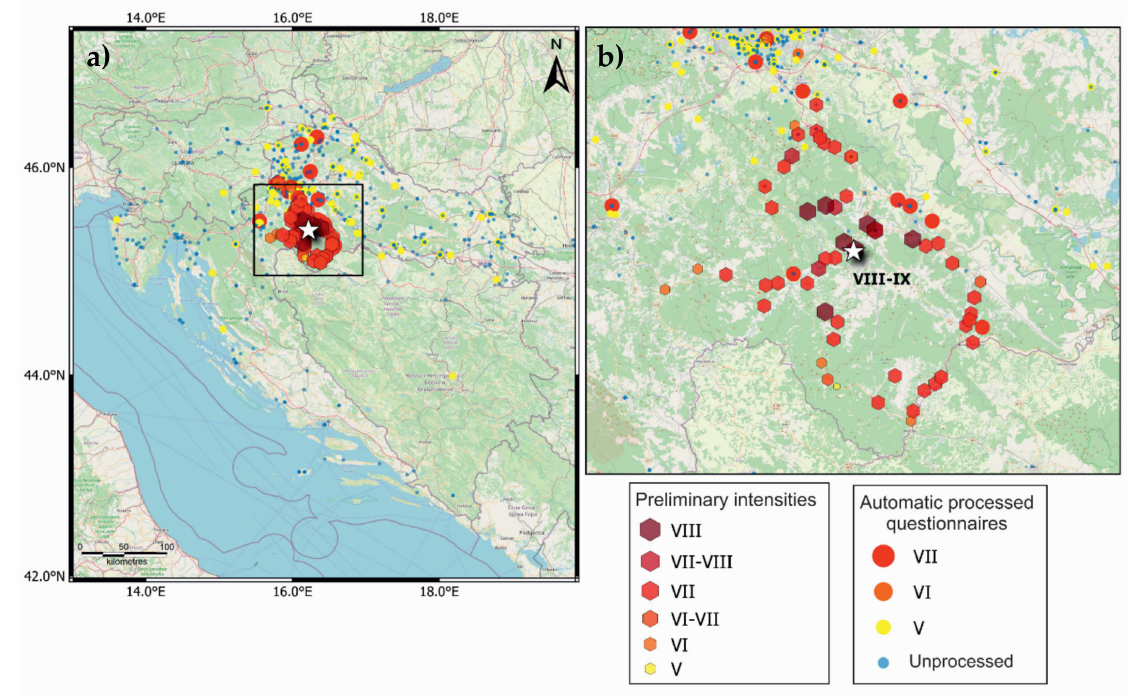
Figure 3. ( a ) A preliminary intensity map for the M6.2 Petrinja 2020 earthquake, which was obtained by automatic processing of questionnaires (circles) and by a macroseismic field survey (preliminary values, which are marked by hexagonal shapes); and ( b ) Intensities in the wider Petrinja area, which is indicated by a rectangle in ( a )